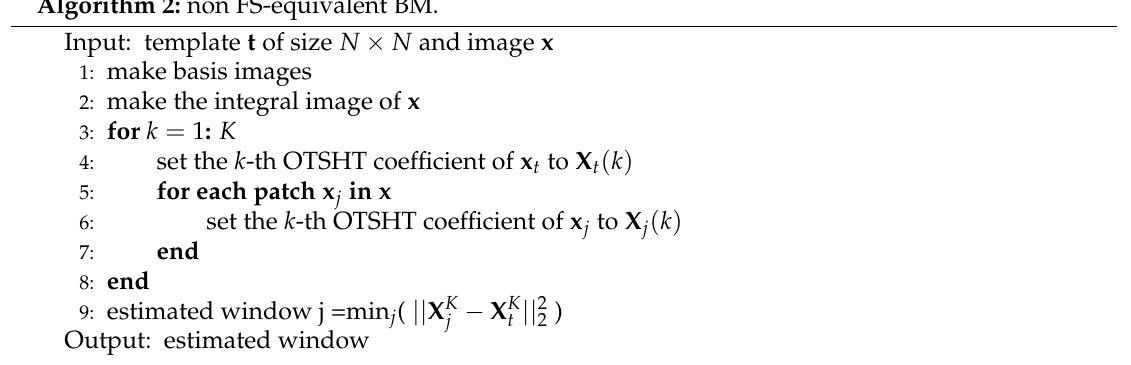
Algorithm 2: non FS-equivalent